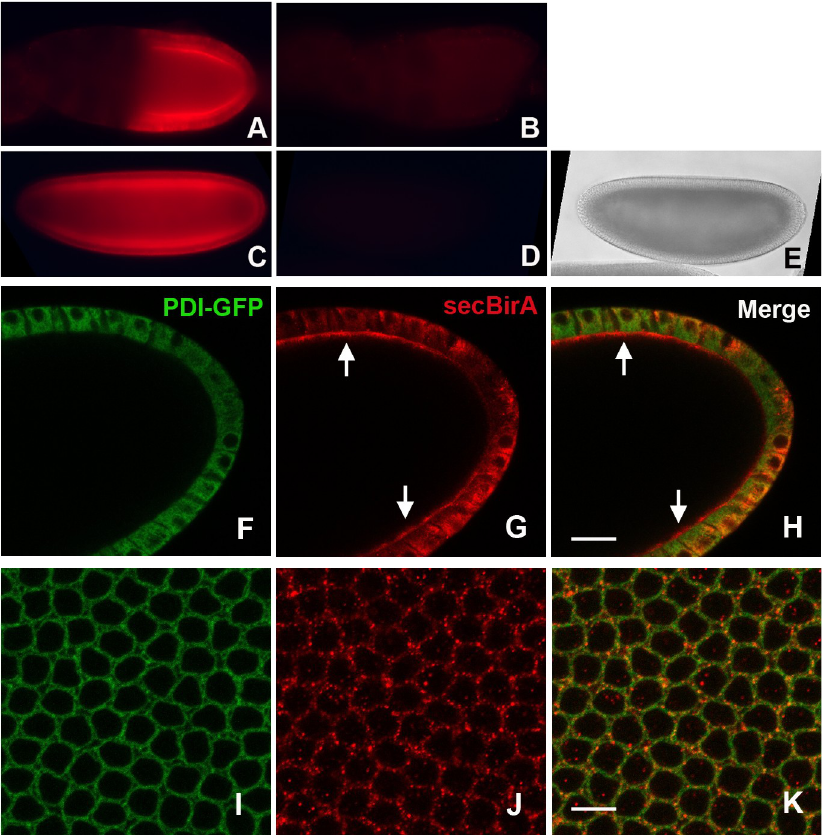
Fig 2. Visualization of the distribution of secBirA expressed in Drosophila ovaries and embryos. Fluorescent whole mount images of stage 10 egg chambers from a female expressing secBirA under the control of the CY2-Gal4 driver (A) and from a female expressing the CY2-Gal4 driver alone (B) photographed under similar exposure conditions. Whole mount images of blastoderm stage embryos from a female expressing secBirA under the control of the nanos- Gal4 :: VP16 (C) and from a female expressing nanos-Gal4 ::VP16 alone (D), photographed under identical exposure conditions. Panel E shows a bright field image of the same field of view shown in panel D, displaying the embryo that cannot be visualized under fluorescence illumination in panel C. Confocal optical sections of the follicle cell layer surrounding the oocyte of a stage 10 egg chamber (F, G, H) and of the surface view of a syncytial blastoderm stage embryo (I, J, K) expressing the ER marker PDI-GFP [63] (F, I) and stained with anti-BirA (G, J). (H) and (K) show merged images of the PDI-GFP expression and secBirA staining patterns in the follicle cell layer and the embryo, respectively. Note that PDI-GFP, which is known to be localized to the ER, and secBirA do not exhibit extensive colocalization. Although secBirA bears an ER-retention signal it appears to be secreted, as shown by its presence in the perivitelline space between the apical surface of the follicle cells and the large developing oocyte [see arrows in (G), (H)]. secBirA exhibits a punctate distribution in the syncytial blastoderm embryo (J, K). The scale bars represent 22.5 microns in (H) and 7.5 microns in